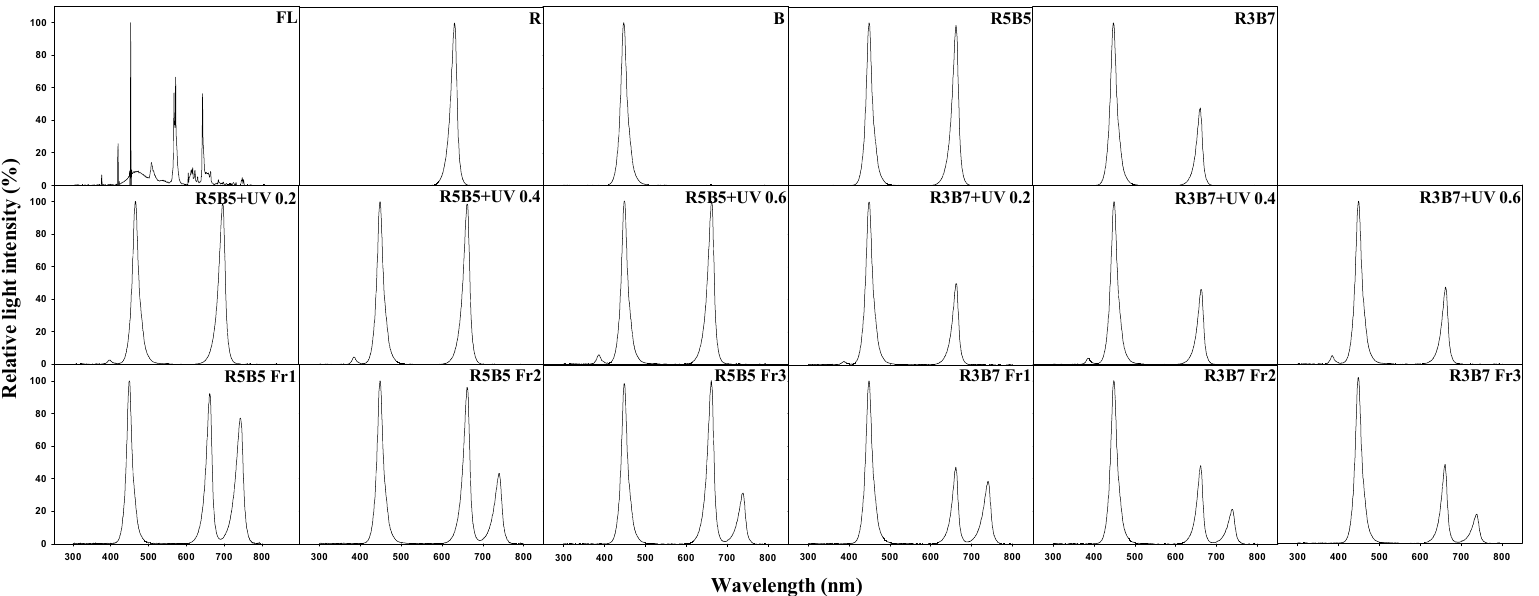
Figure 1. The spectral distribution of light used in the experiments.